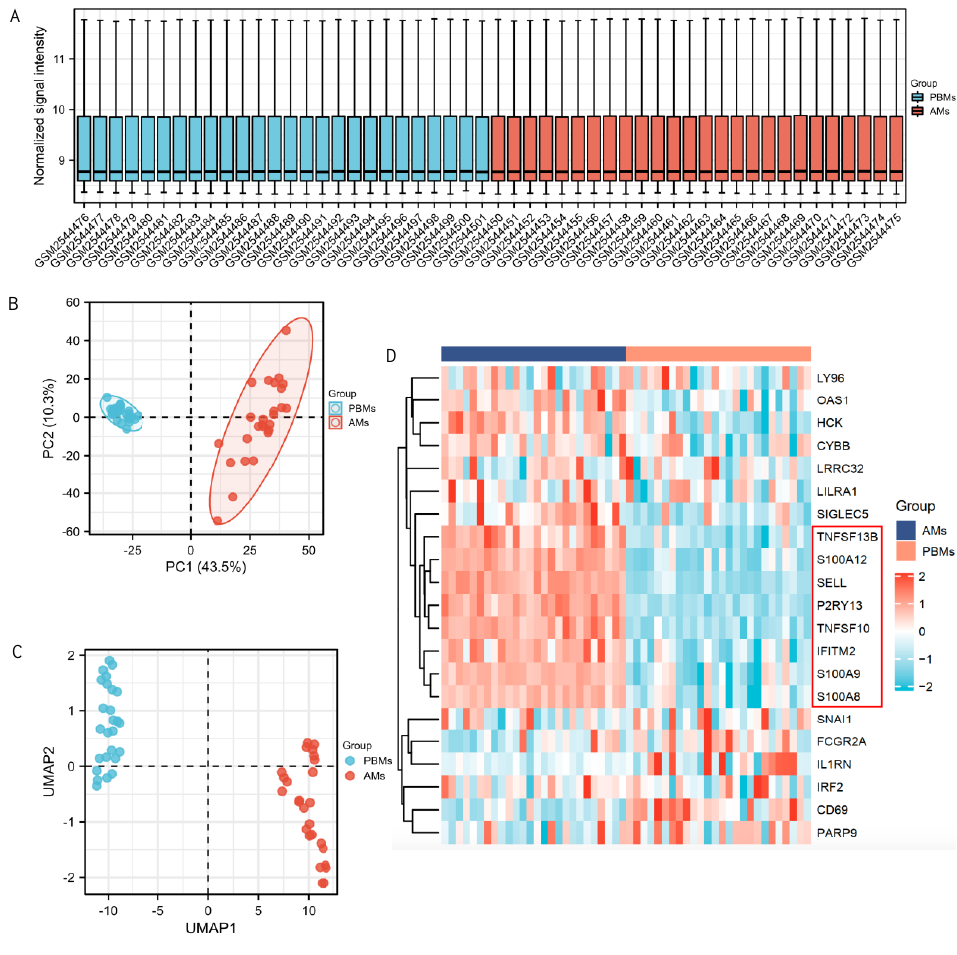
Figure 7. Identification of common DEGs between paired alveolar macrophages (AM) and peripheral blood monocyte (PBM) samples in acute respiratory distress syndrome (ARDS) patients. ( A ) The data were normalized. ( B , C ) PCA and UMAP plots indicated that the different categories (AM and PBM samples) were well differentiated. ( D ) The common DEGs obtained from Figure 2E were selected to make the heatmap. The expression data for IRF9 was missing and therefore not shown.